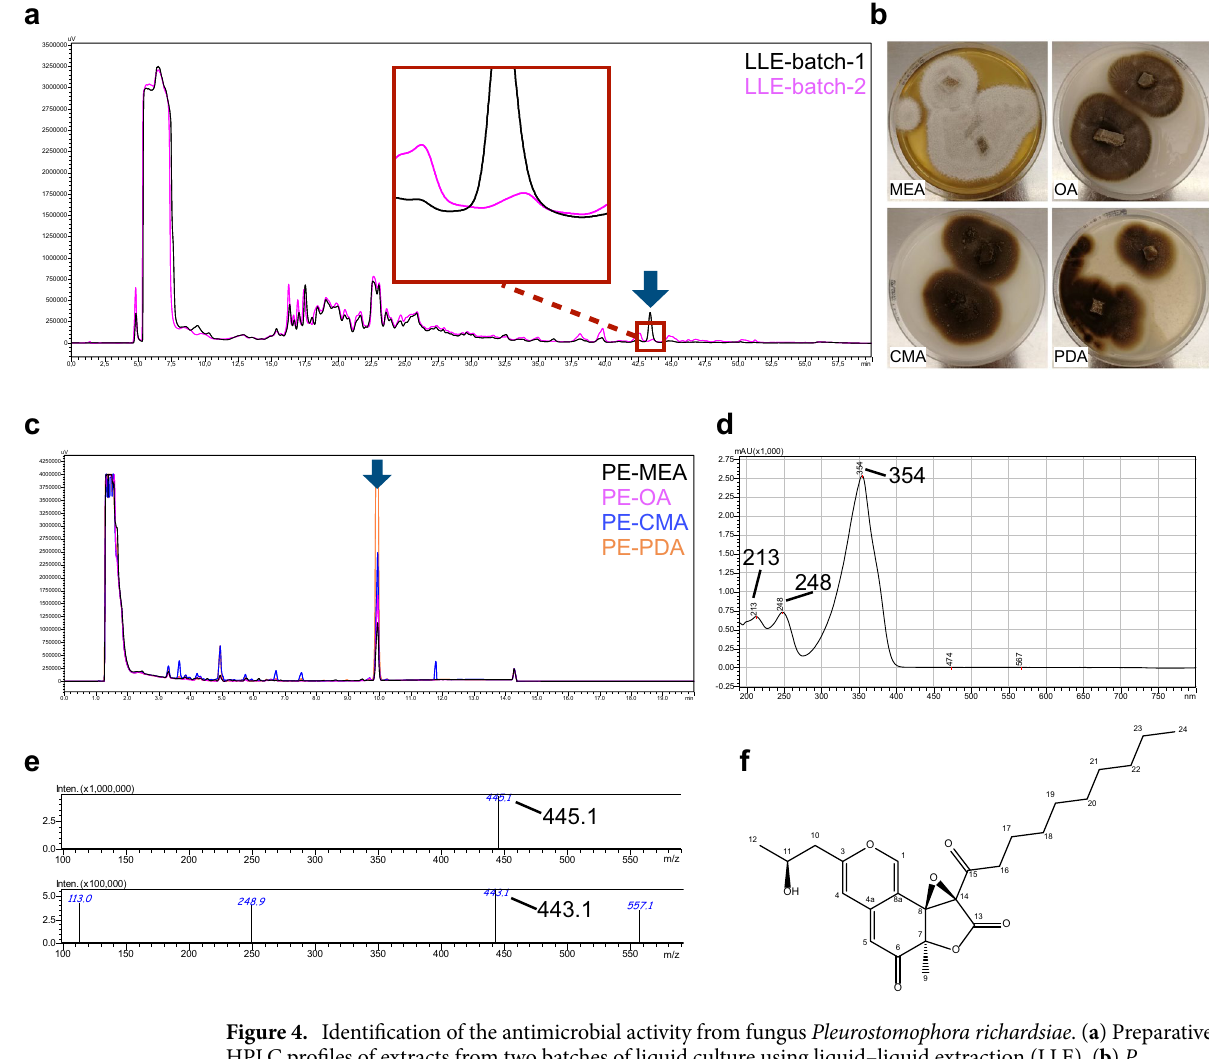
Figure 4. Identification of the antimicrobial activity from fungus Pleurostomophora richardsiae . ( a ) Preparative HPLC profiles of extracts from two batches of liquid culture using liquid–liquid extraction (LLE). ( b ) P. richardsiae cultured on different kinds of agar. ( c ) Comparison of different plate extractions (PE) on analytical HPLC. ( d ) UV spectrum of the active compound from this fungus. ( e ) Mass spectrum of the active compound. ( f ) Chemical structure of BAB, the antimicrobial activity from P. richardsiae